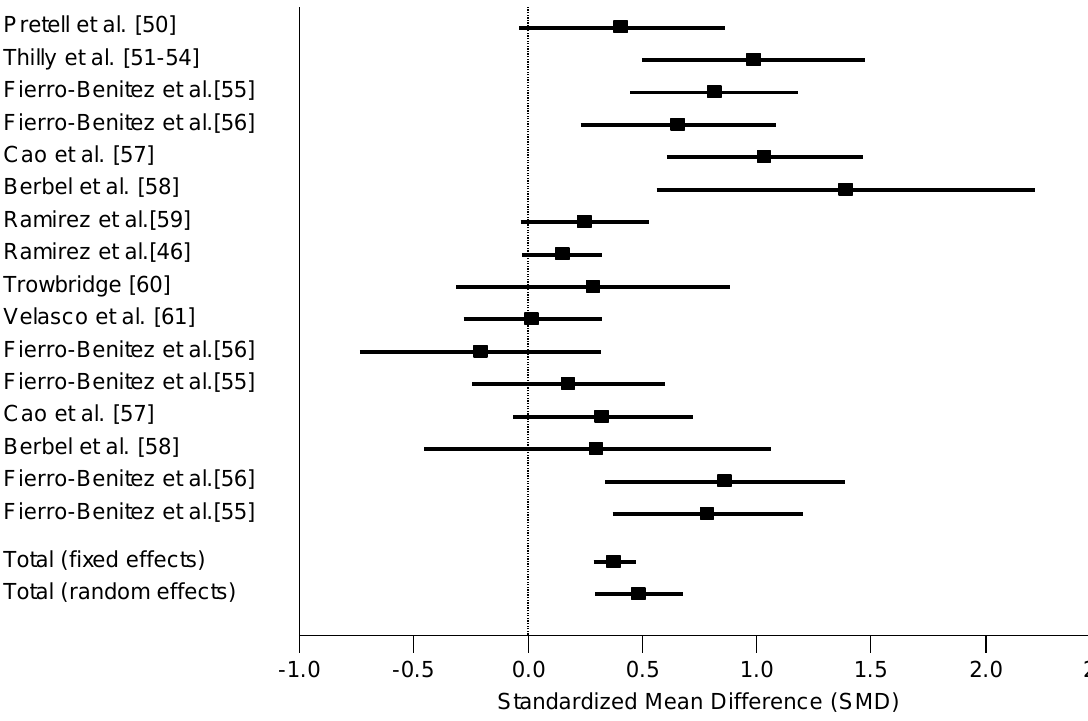
Figure 2. Forest plot for effect size (Standard mean difference SMD and 95% confidence interval) of iodine on mental development of children, intervention studies (The studies were heterogeneous ( Q = 54.81, df = 15, p < 0.0001). The random effects model was therefore more